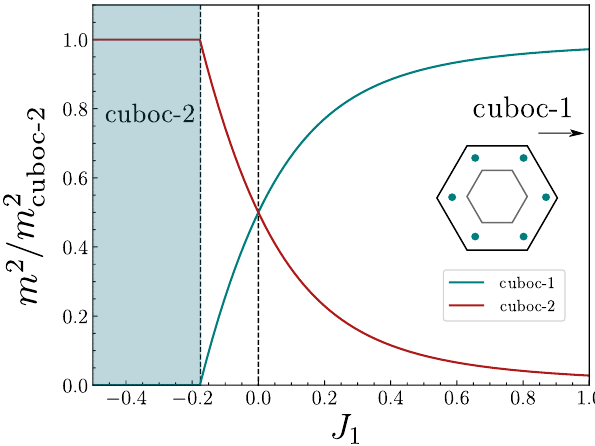
Figure 4: Order parameter squared (normalized with respect to its value in the cuboc- 2 state) as a function of J , indicating the continuous transition between the cuboc-2 1 = 0.2. This is true for all J > 0 where the and AFMd phases for J χ = 1 and J d d cuboc phases are stable. The red (light-blue) curve shows the normalized Bragg peak = 0, an octahedral intensity at the cuboc-2(1) ordering wave vectors. At the point J 1 state maximizing the staggered chirality emerges. The phase transition to the cuboc- = 1 (not shown). Inset: structure 1 is slower and takes place in the vicinity of J 1 factor for the cuboc-1